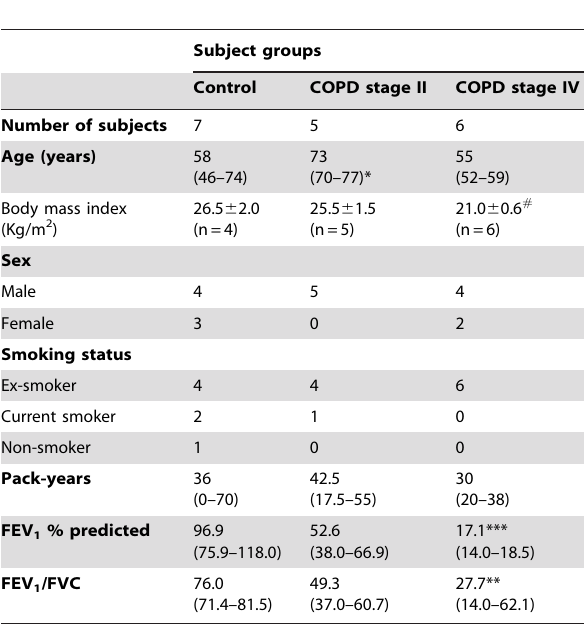
Table 1. Clinical characteristics of the subjects involved in the studies.